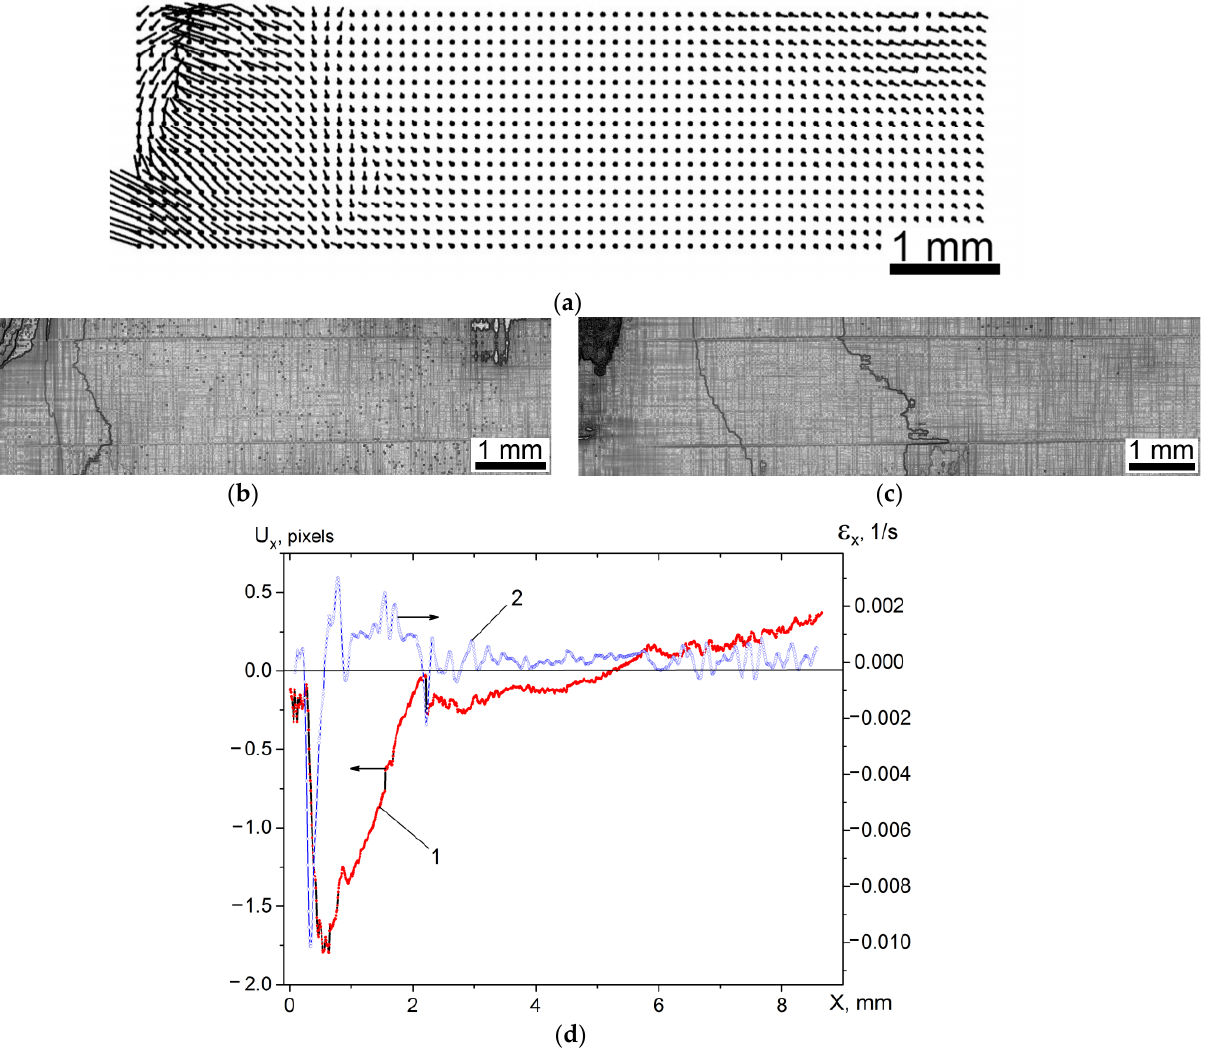
Figure 7. View of the displacement field ( a ), pseudo images of the deformation structure ( b , c ), longitudinal displacements (1) along the sample midline U x ( x , y = y m /2 ) ( d ) and longitudinal tensor component (2) ε xx ( x , y = y m /2 ) at ε = 0.013, ∆ ε = 0.012, T = 1. Zero